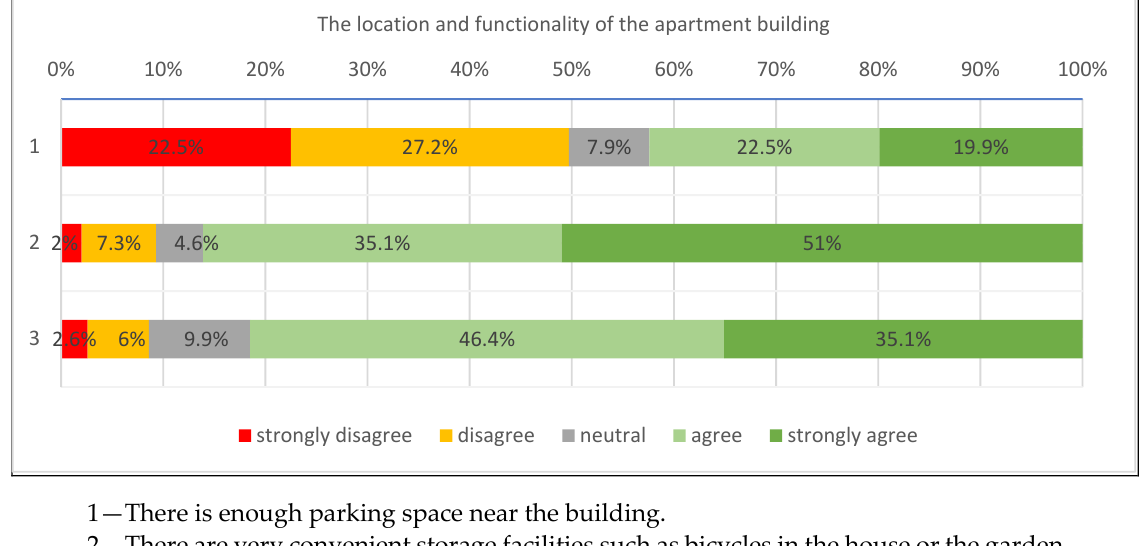
Figure 17. The location and functionality of the apartment building. Figure 18 indicates the following features in the apartment building in which the